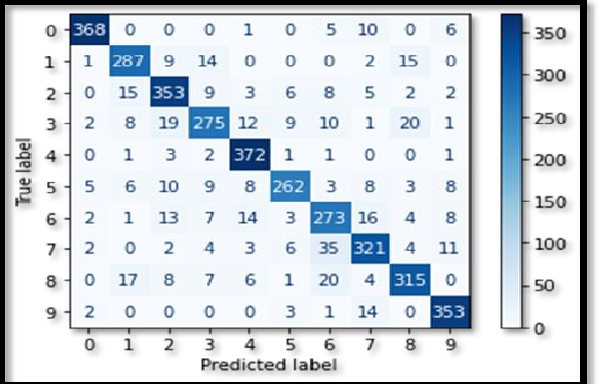
Fig. 4 . Statistical data of confusion matrix on tomato dataset